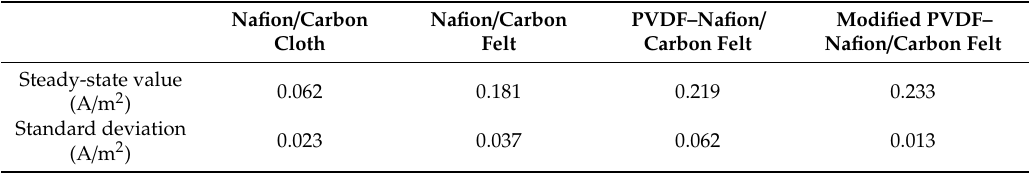
Table 1. Steady-state values and their standard deviations of current density.